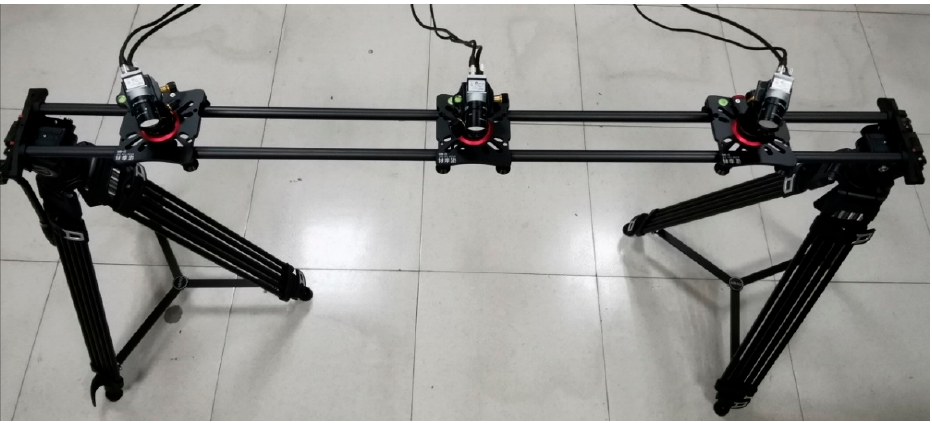
Figure 1. Physical map of trinocular stereo vision (TSV).